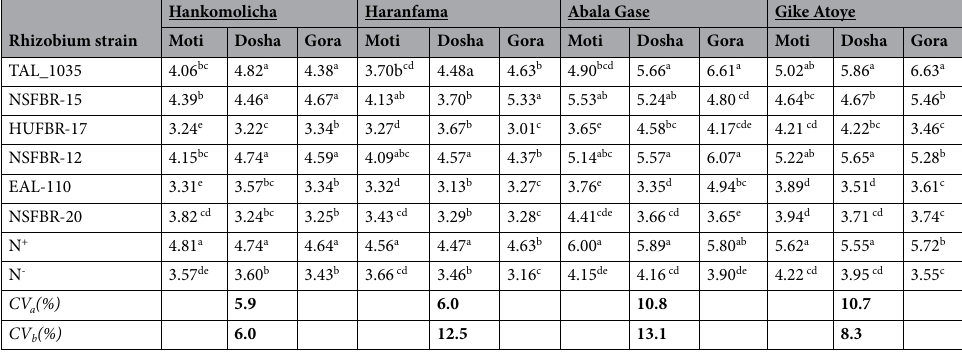
Table 9. Rhizobium strain × faba bean variety interaction effects on shoot to root ratio at the study locations. Mean values in the same column with different letter(s) are significantly different at p ≤ 0.05 probability level.